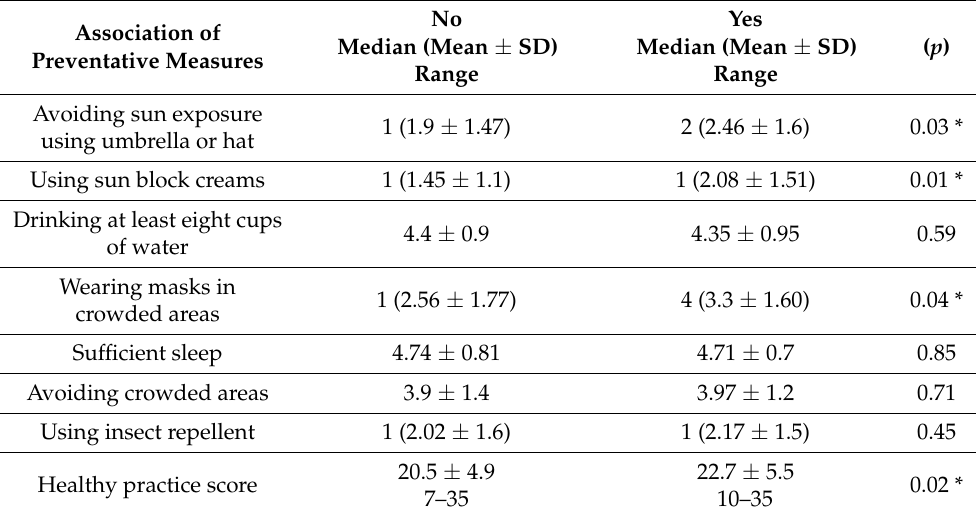
Table 7. Report the association between receiving some form of health education and practicing of preventative measures by pilgrims.